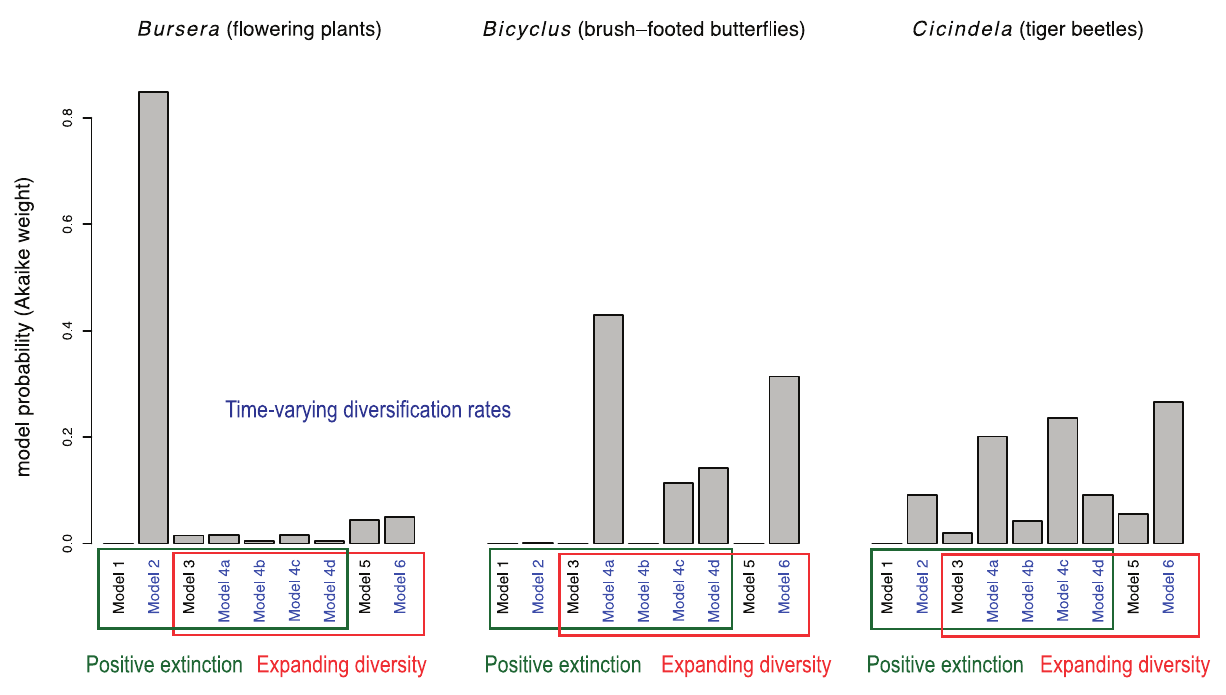
Figure 4. Dynamics of diversification in three empirical phylogenies. Each bar represents the probability—measured as the Akaike weight— that the phylogeny arises from the corresponding model, among the set of nine models considered. The phylogeny of the genus Bursera , comprising 73% of known species in that genus, overwhelmingly supports Model 2. Thus, the Bursera phylogeny is consistent with the hypotheses that diversity is saturated and that the turnover rate varies over time. The phylogeny of the genus Bicyclus , comprising 68% of known species, is consistent with the hypotheses that diversity is expanding and that speciation rates vary. The phylogeny of the genus Cicindela , comprising 84% of recognized species, is also largely consistent with the hypotheses that diversity expands and rates vary. However, the dynamics of diversification are less clear-cut in the Cicindela phylogeny, because models with saturated diversity and constant rates also have positive probabilities. Although there is high confidence for the presence of extinction in the phylogeny of Bursera , models with or without extinction are about equally likely in the phylogenies of Bicyclus and Cicindela . Models with time-varying diversification rates are written in blue text.